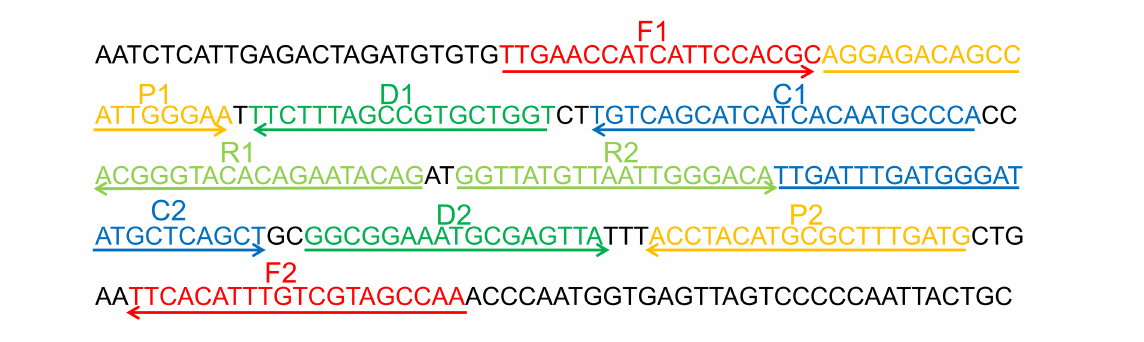
FIGURE 1 Appropriate primer design for CVA16-MCDA-LFB assay. The nucleotide sequences of the sense strand of VP1 are listed. Right arrows and left arrows indicate sense and complementary sequences that are